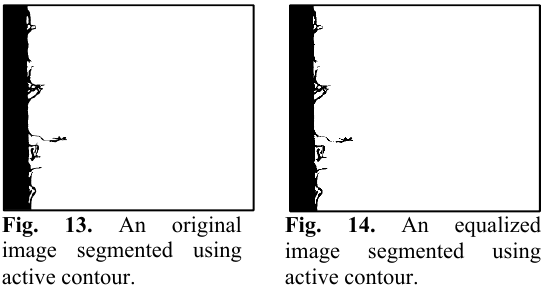
Fig. 14. An equalized image segmented using active